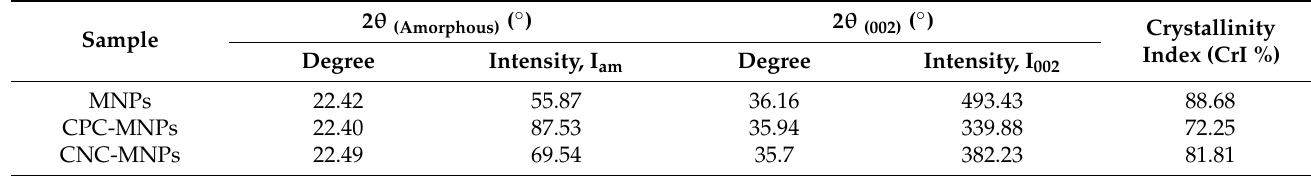
Table 1. Crystallinity Indices for MNPs, CPC-MNPS, and